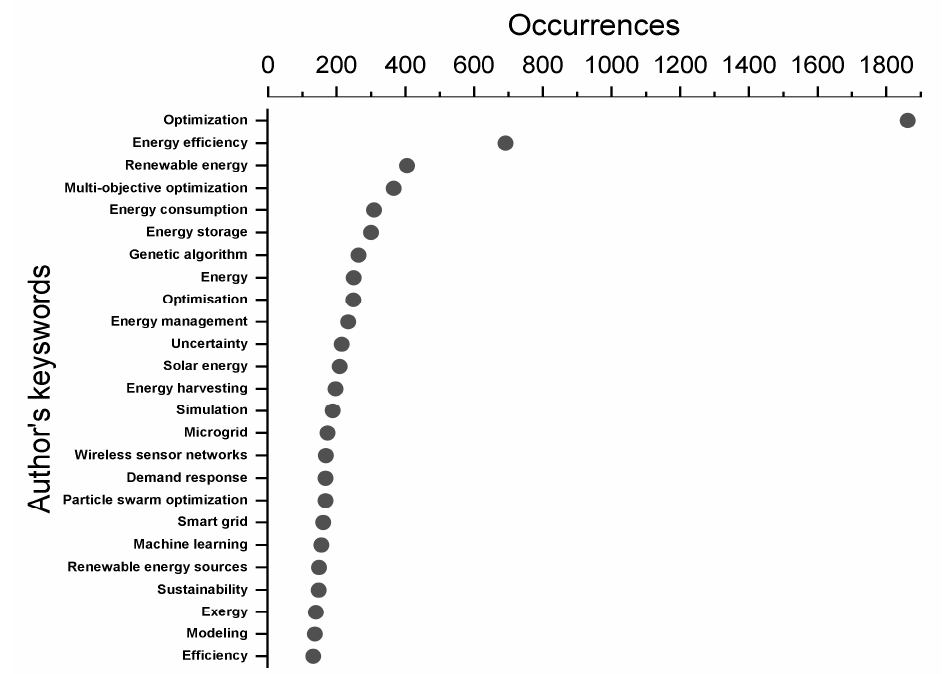
Energies 2023 , 16 , x FOR PEER REVIEW Figure 11. Most relevant keywords. Data obtained from Web of Science. Figure 11. Most relevant keywords. Data obtained from Web of Science.